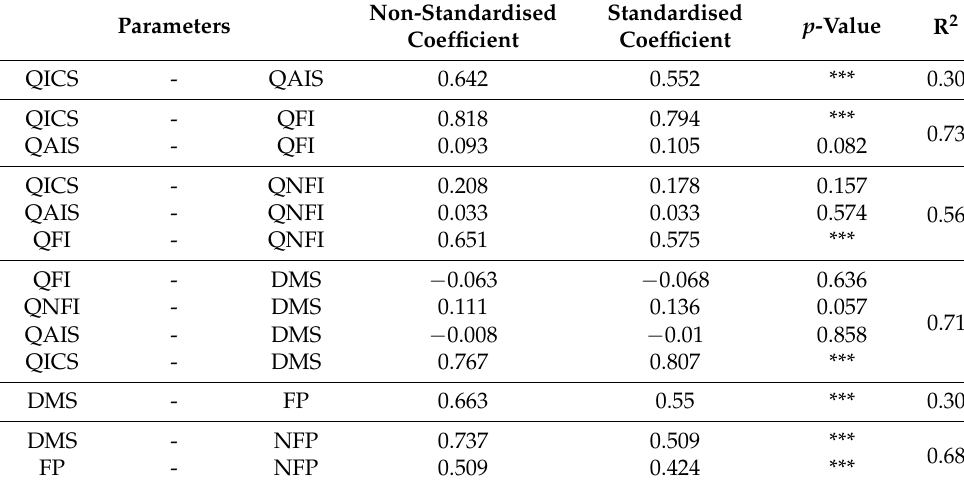
Table 3. Results of the assessment of the initial theoretical